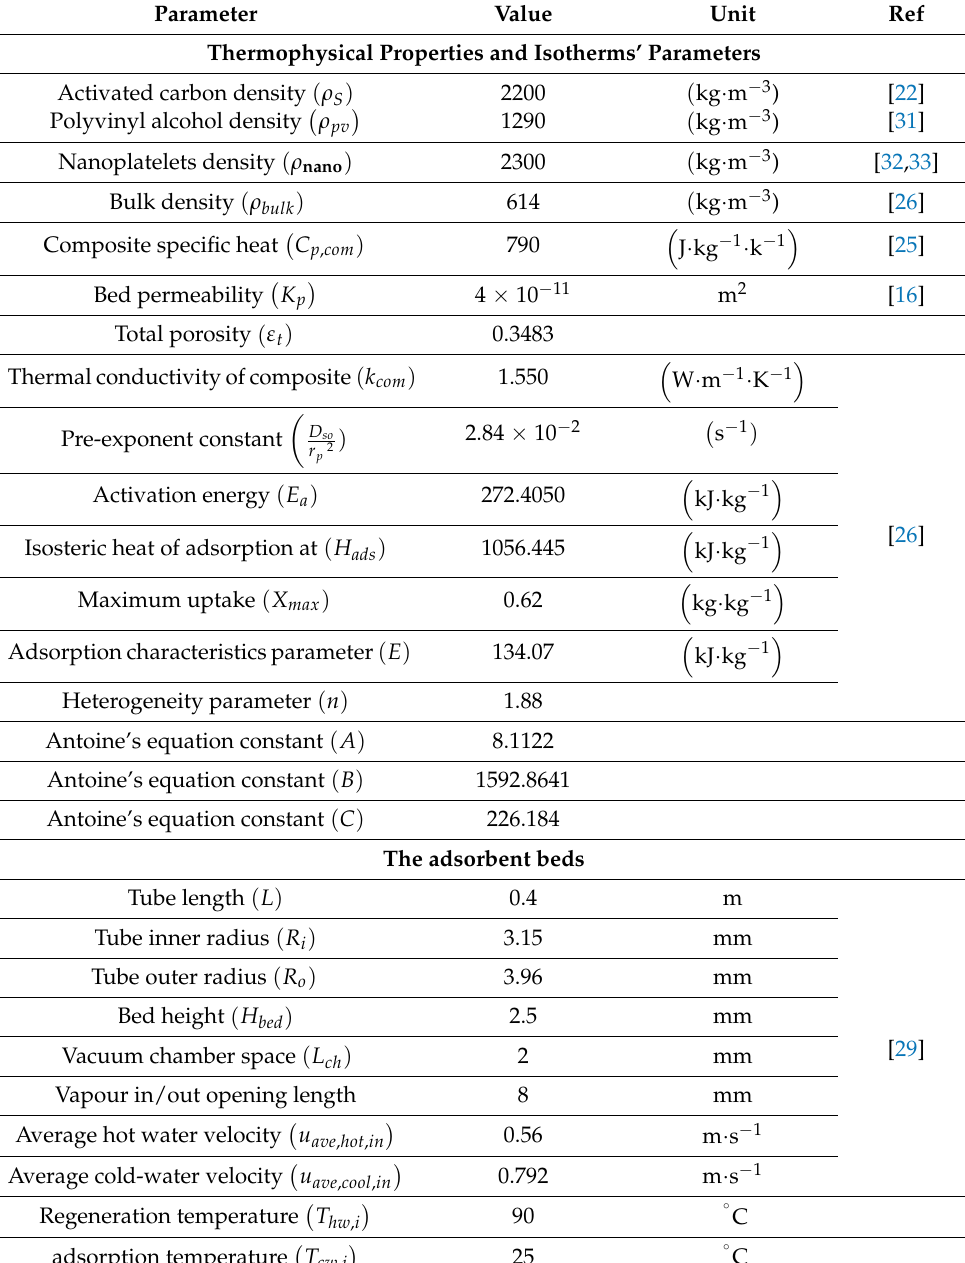
Table 1. The values of the parameters set in the simulation model. Parameter Value Unit Ref Thermophysical Properties and Isotherms’ Parameters Activated carbon density ( ρ S ) 2200 ( kg · m − 3 ) [22] (cid:0) (cid:1) ρ pv Polyvinyl alcohol density